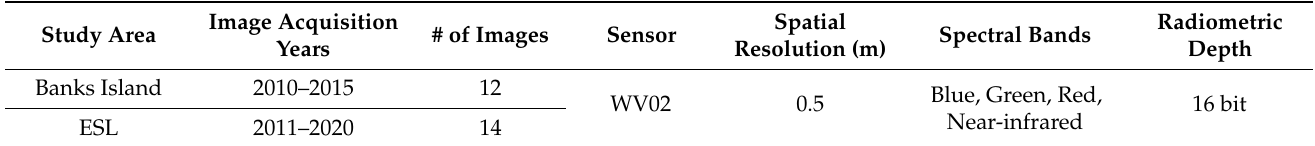
Table 3. General characteristics of the satellite imagery utilized in hand-annotation.